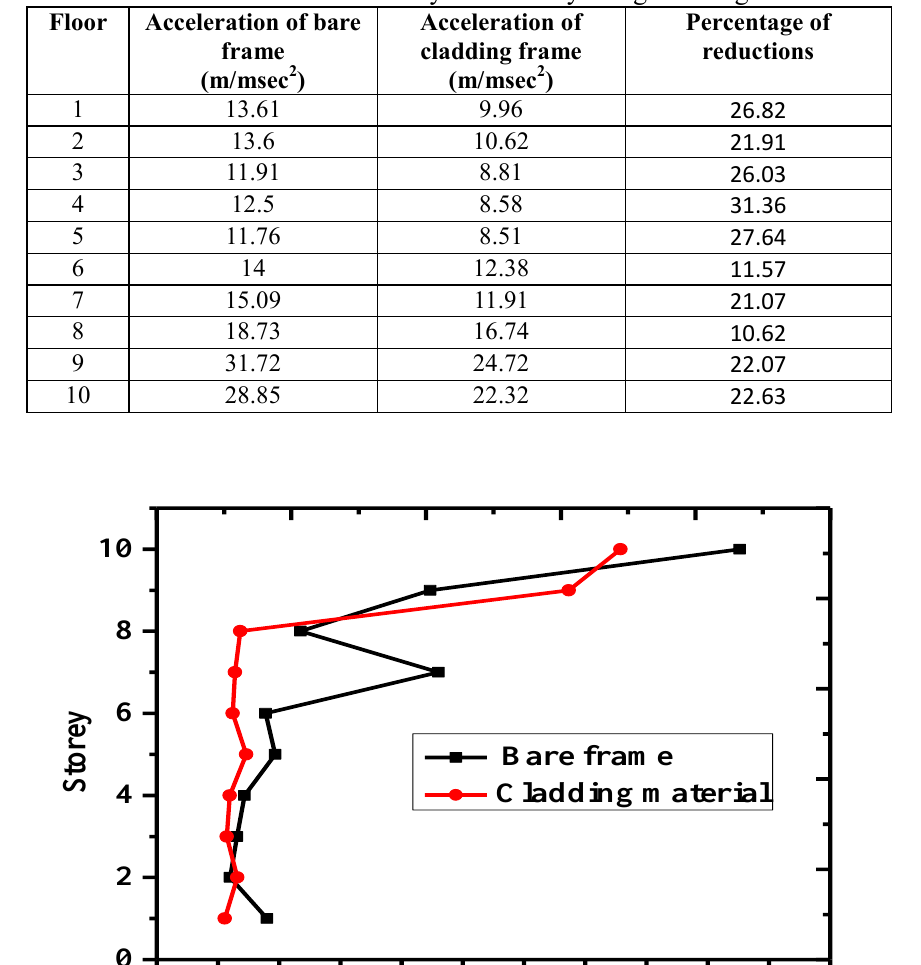
Percentage of reduction of acceleration of 10 storey structure by using cladding material.